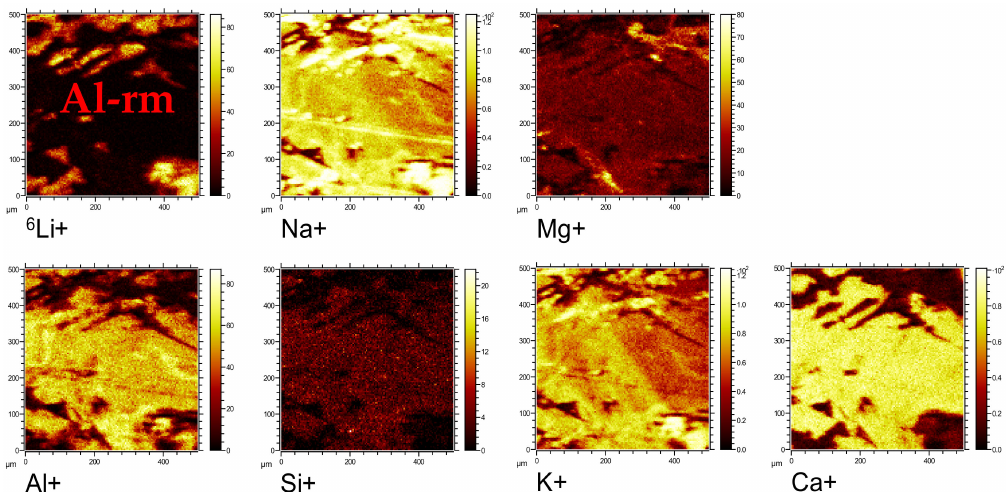
Figure 6. Details of the lateral intensity distributions of selected positive isotope-resolved secondary ion signals of an aluminum-rich phase (Al-rm) containing Na, Mg and K, indicating a melt segregation.